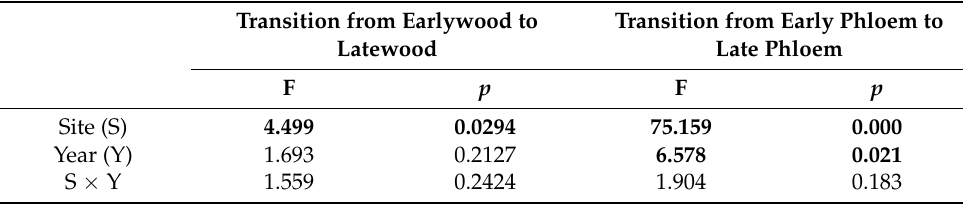
Table 3. Differences in timings of the transition from earlywood to latewood and early phloem to late phloem as evaluated using mixed linear models in which ‘year’ was the repeated factor and ‘site’ was the fixed factor. Bold values are significant at a 0.05